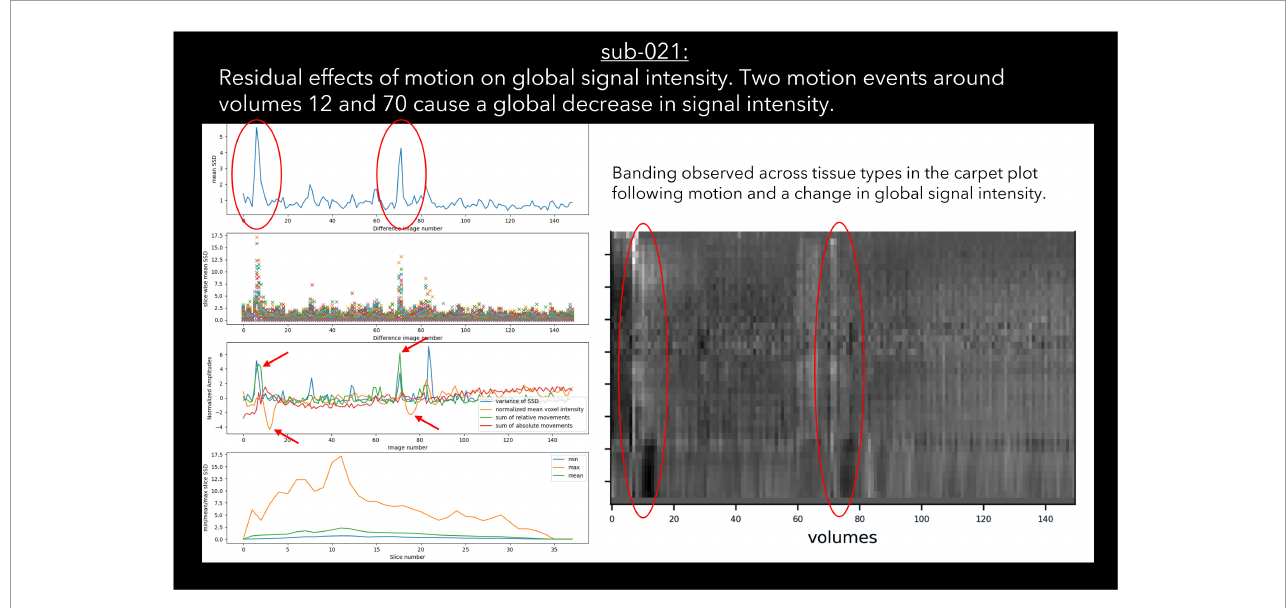
FIGURE4 An example case of global signal loss following motion detected using output from pyfMRIqc.